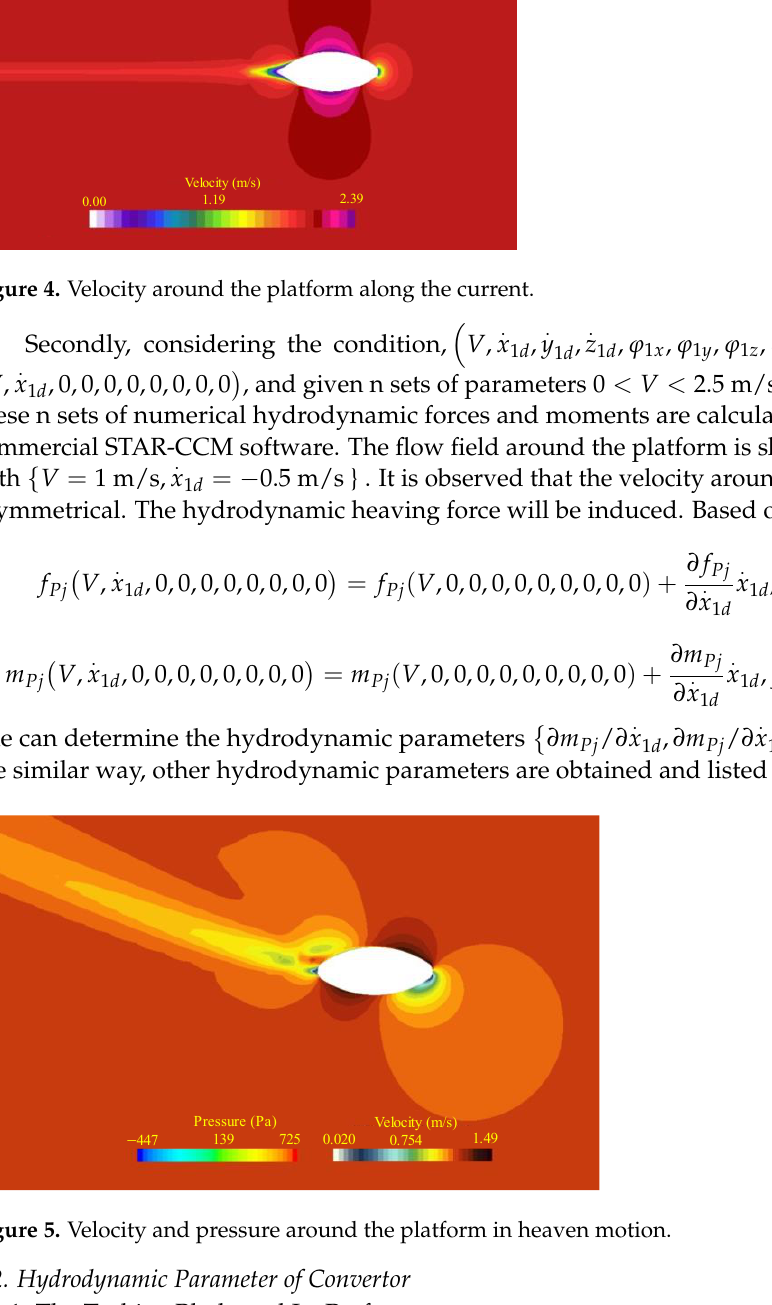
Figure 5. Velocity and pressure around the platform in heaven motion.